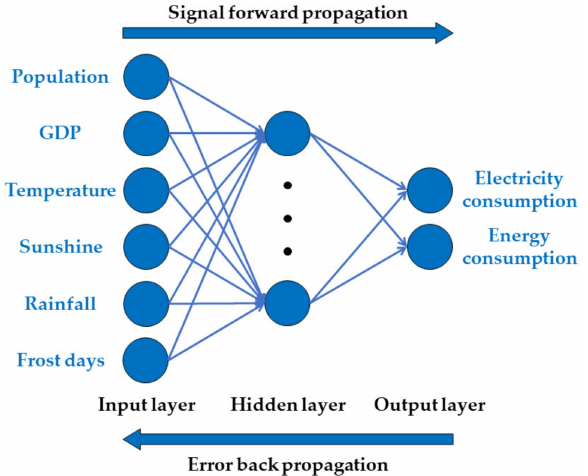
Figure 1. BP-NN model used in this